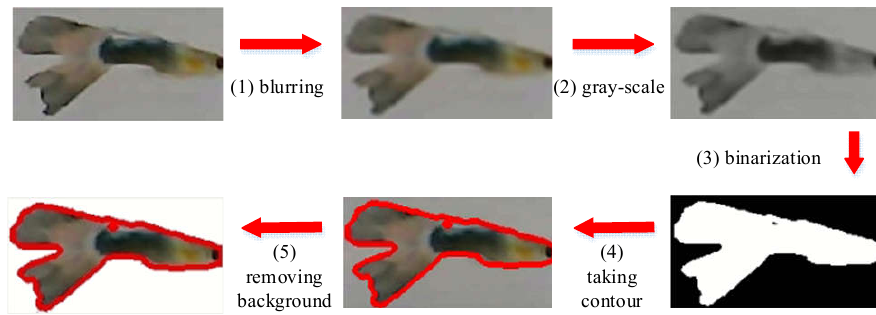
Figure 12. Illustration of fish image pre-processing.